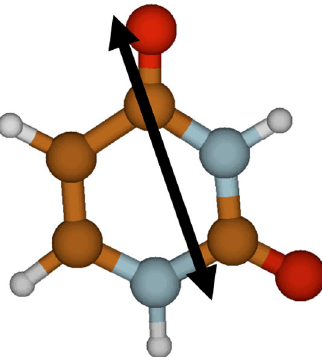
FIG. 1. Geometry of ground-state uracil and transition dipole moment for the S 0 ! S 2 electronic